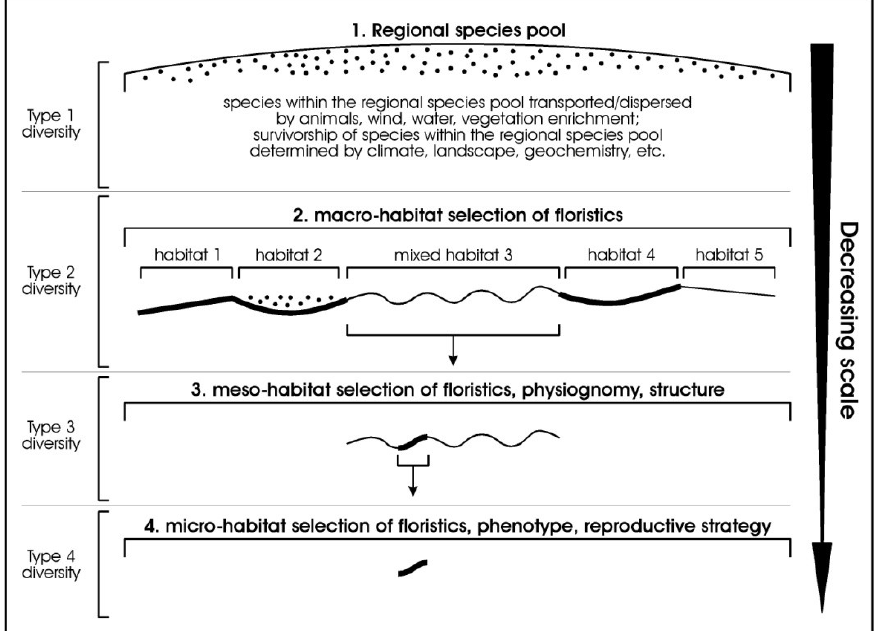
Figure 2. Idealised diagram showing progressive decreasing change of scale for a regional species pool to macro-scale habitat-selected floristics, to meso-scale habitat-selected floristics, physiognomy, structure, and phenology, to micro-scale habitat-selected floristics, phenology, and reproductive strategy. Five idealised habitats are illustrated at the macro-habitat